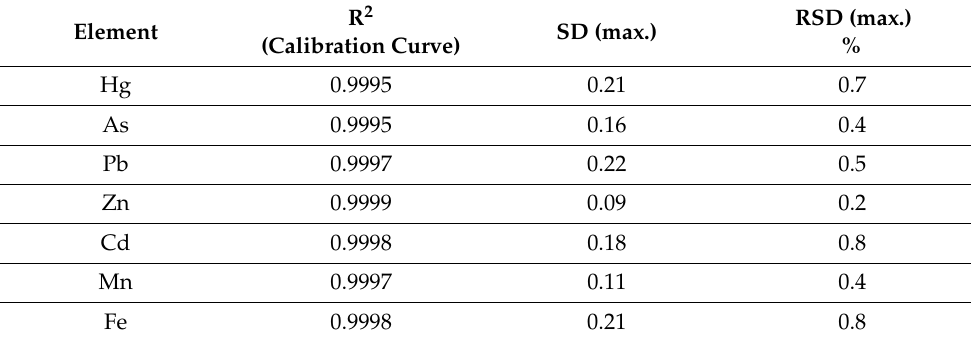
Table 3. AAS analytical errors.